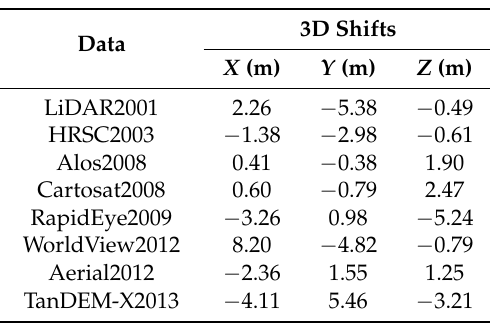
Table 2. Calculated shift values for three directions (reference: